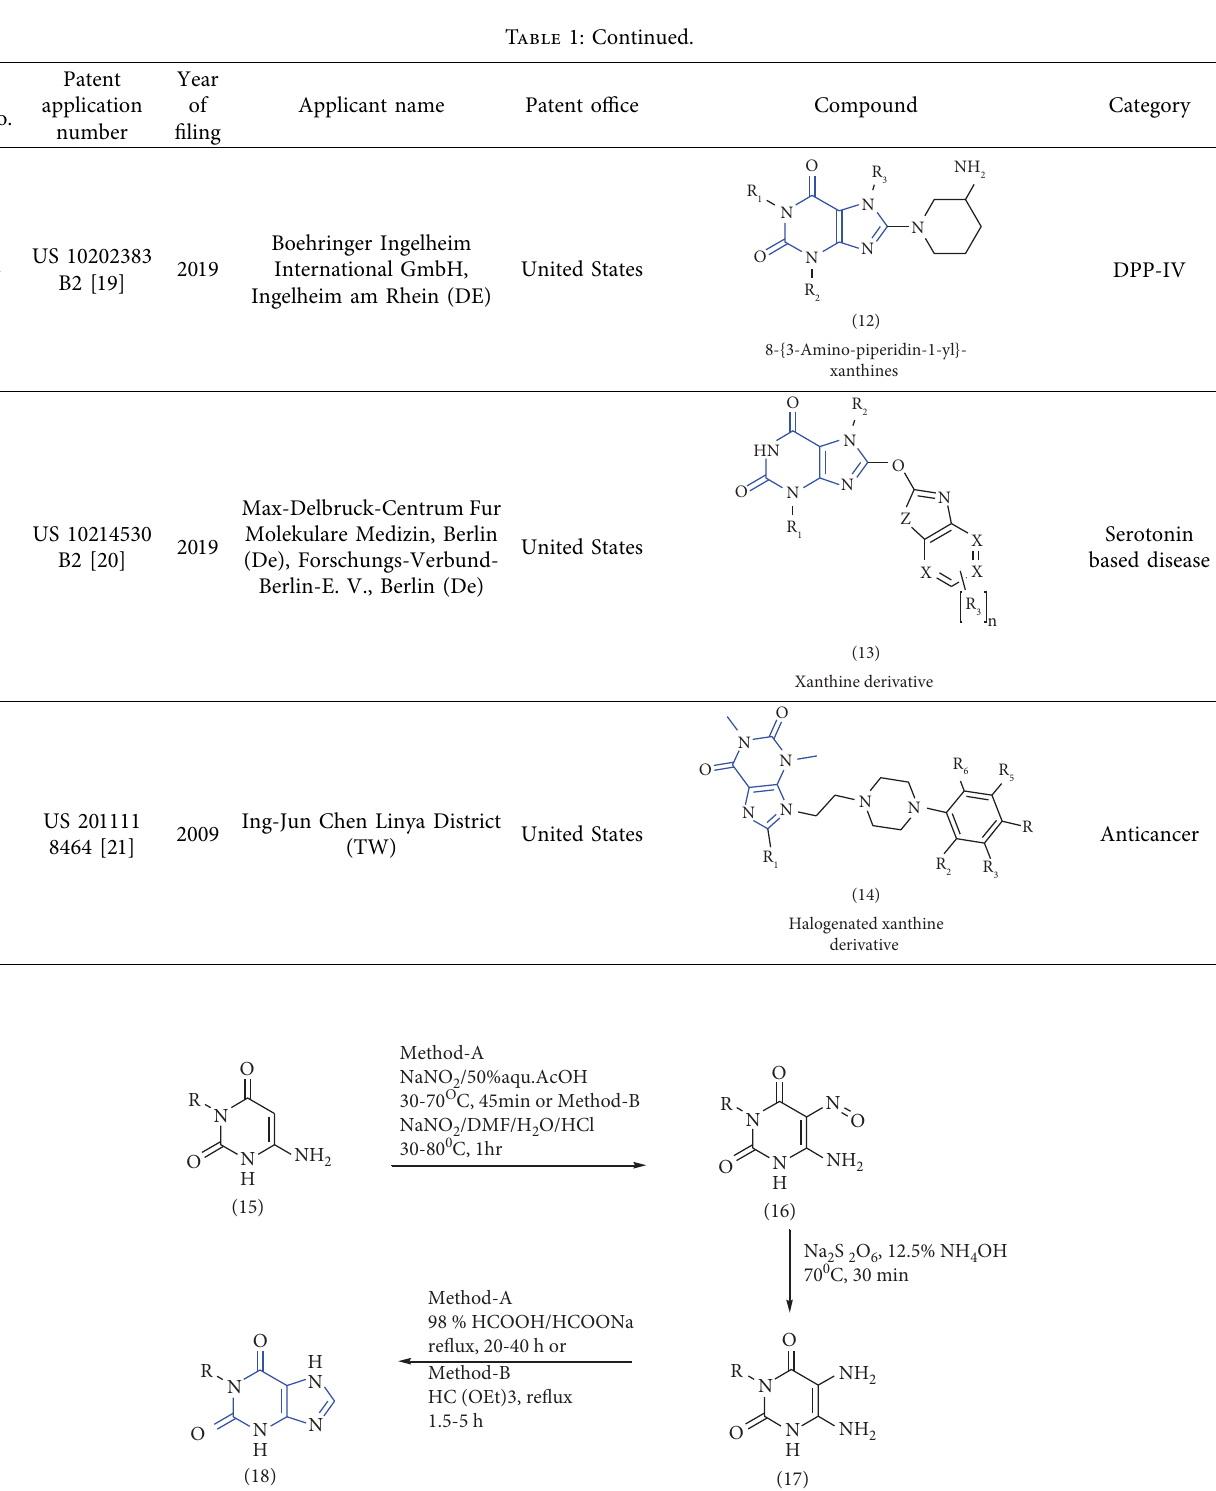
Scheme 1: Synthetic procedure for substituted xanthines by Traube’s